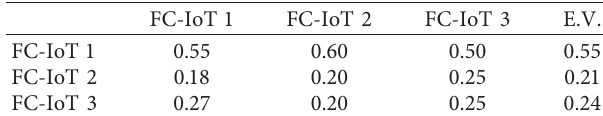
Table 8: Pairwise comparison of architecture